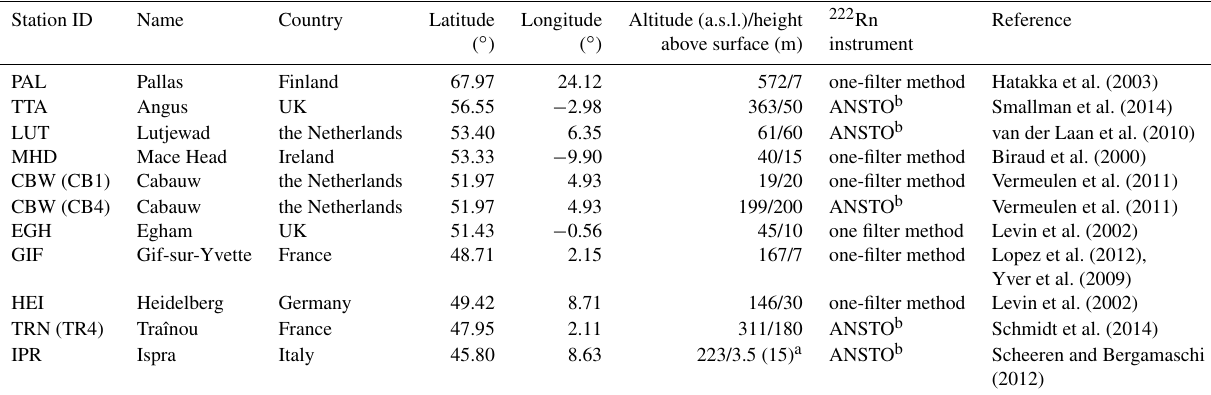
Table 1. Description of the different surface stations measuring 222 Rn activity concentrations. The locations of the stations are shown in Fig. 1. CB1 and CB4 are the 20 and 200m levels of the Cabauw tower, respectively. Altitude is the sampling altitude above sea level and height is the sampling height above the